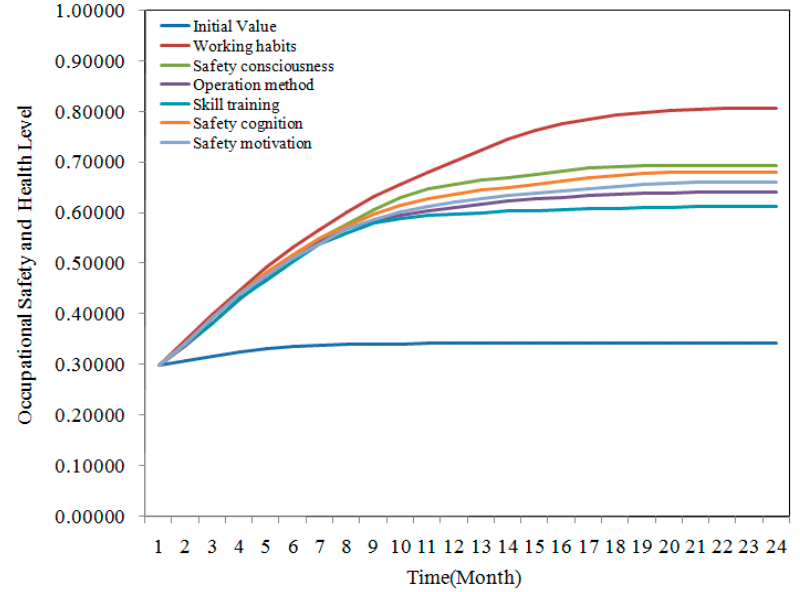
Figure 7. SD simulation of human factor measures.